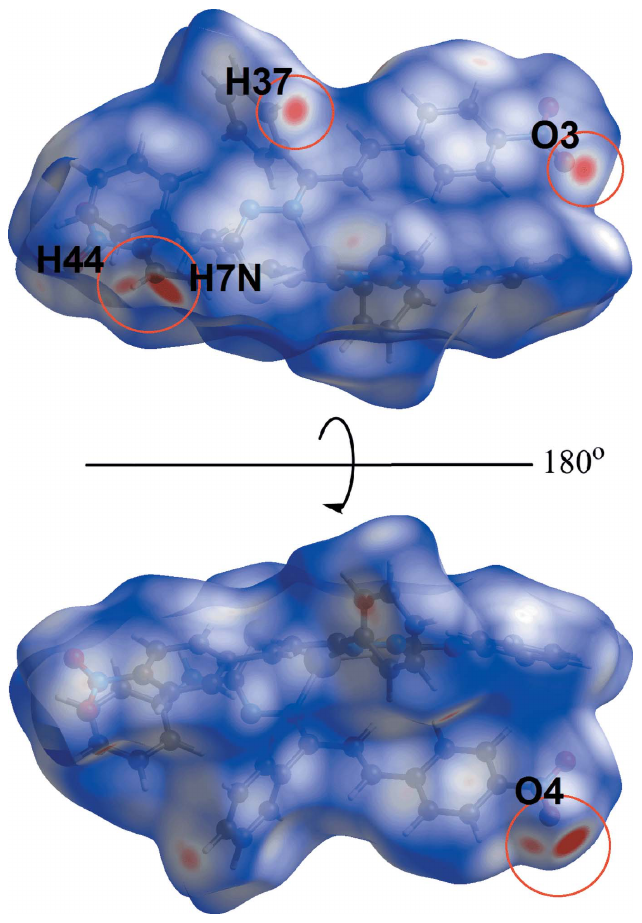
Figure 4 Two views of the Hirshfeld surface mapped over d norm for (I) in the range (cid:4) 0.239 to +1.045 arbitrary units, highlighting N—H (cid:3)(cid:3)(cid:3) O and C—H (cid:3)(cid:3)(cid:3) O contact within red circles.